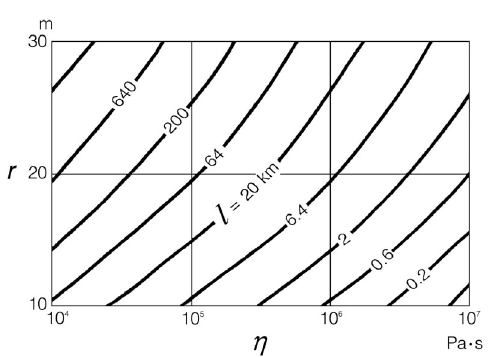
Fig. 3. Flow rate Q is estimated at 7.5 × 10 6 m 3 /day. By means of the Hagen-Poiseuille’s Law, length of conduit l is plotted with two parameters, radius of vent r (m) and macroscopic viscosity η (Pa ⋅ s). l is ex- pressed in km